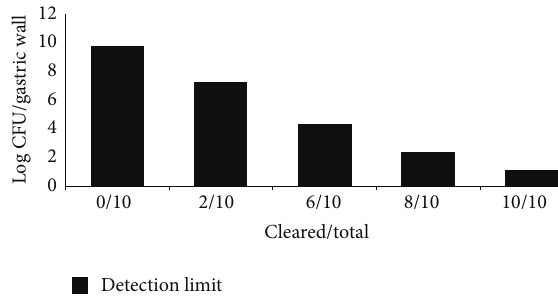
Figure 4: In vivo therapeutic efficacy of silver